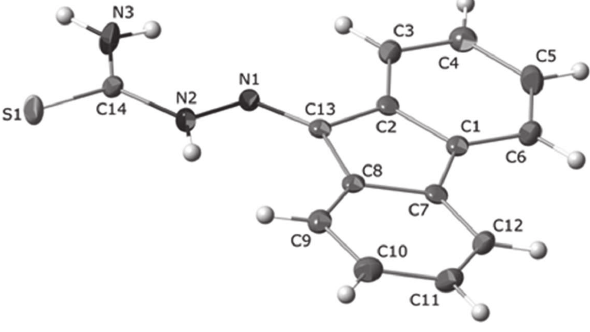
Table 2: Fractional atomic coordinates and isotropic or equivalent isotropic displacement parameters (Å 2